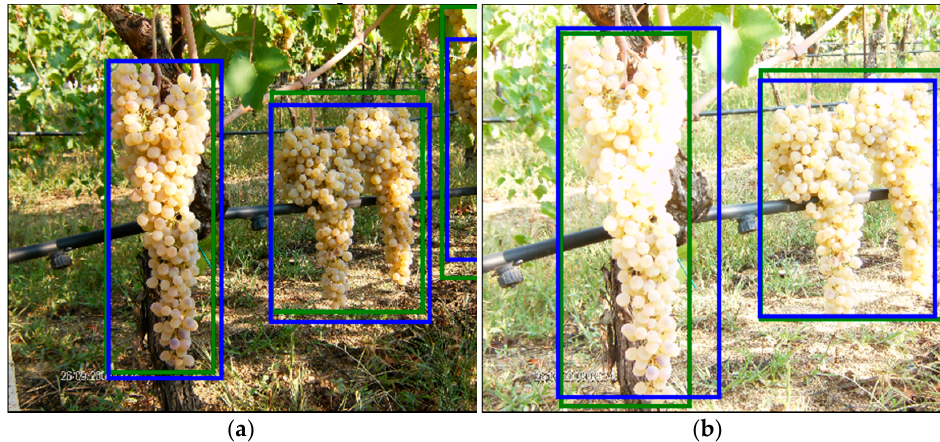
Figure 15. Example of same bunches correctly detected in two similar images. The image ( a ) is significantly overexposed compared to the image ( b ). The green boxes represent the ground truth while the blues ones are the detection results.